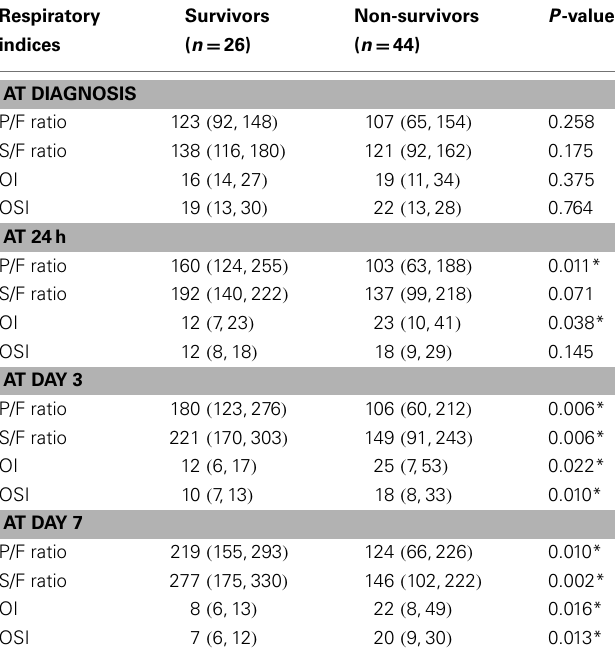
Table 4 | Respiratory indices at the onset, after 24h, on day 3, and on day 7 of diagnosis ofALI/ARDS